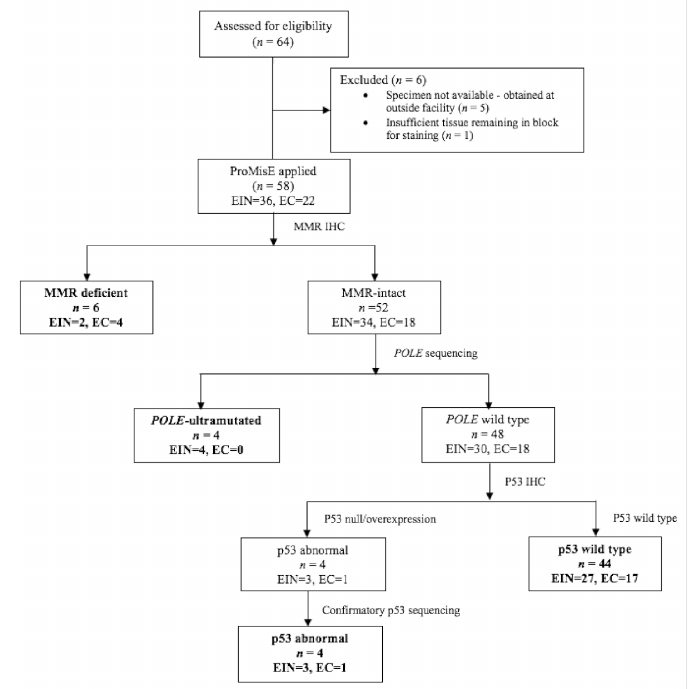
Figure 1. The Proactive Molecular Risk Classifier for Endometrial cancer (ProMisE) molecular classification algorithm [21–23]. Our final cohort included 58 tumors with sufficient tissue for testing. Mismatch repair (MMR) status was evaluated by immunohistochemistry targeting of proteins MLH1, PMS2, MSH2, and MSH6, and tumors were categorized as MMR-deficient if they exhibited loss of any of these proteins. MMR-intact tumors were then evaluated for mutations in the exonuclease domain of the polymerase- ε gene ( POLE ) via single gene sequencing. Tumors with wild-type POLE sequencing were then subjected to IHC for p53, which identified 4 tumors with strong and diffuse expression of p53. Confirmatory p53 sequencing was performed on these 4 samples to ensure accuracy of IHC. Abbreviations: EC, endometrioid endometrial adenocarcinoma; EIN, endometrial intraepithelial